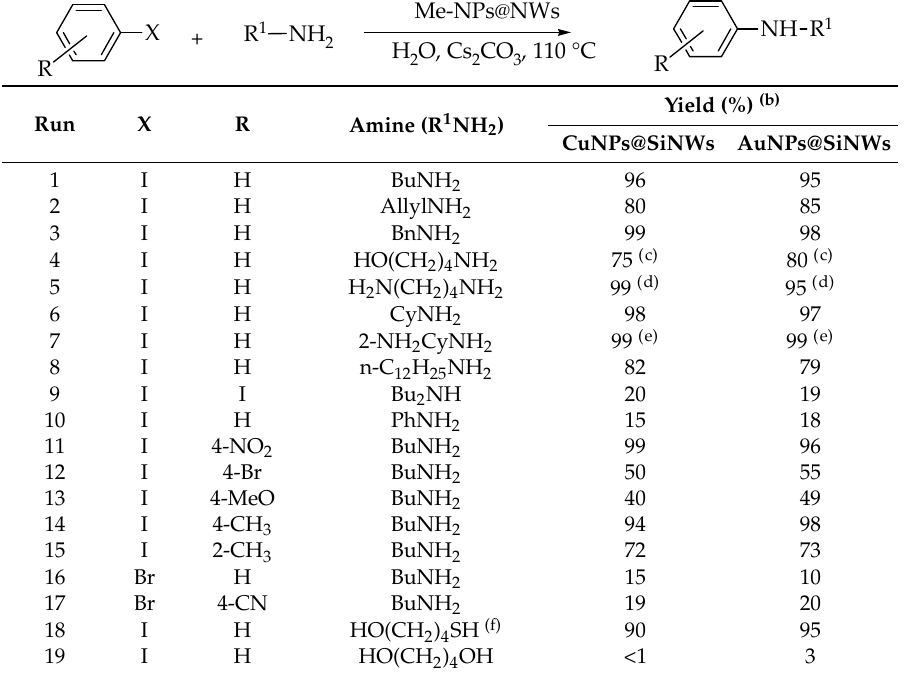
Table 1. Substrate scope in the coupling of aryl halides and amines catalyzed by MeNPs@SiNWs (a) .